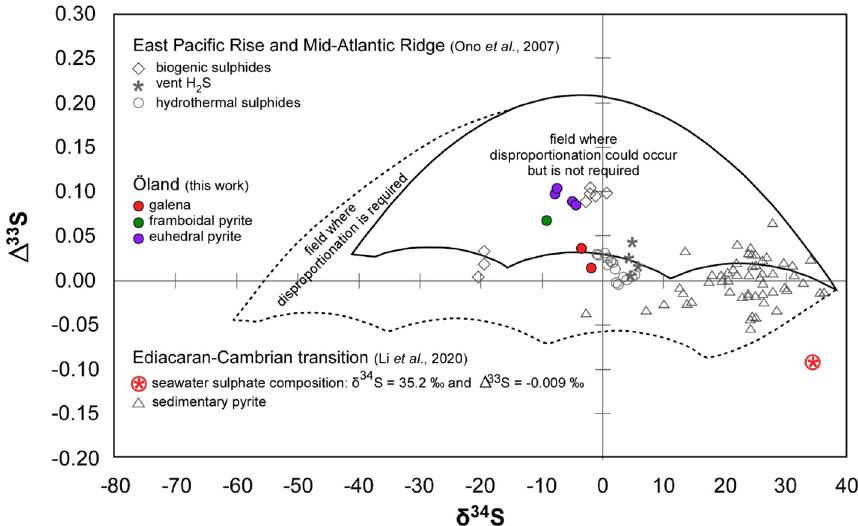
Figure 7. Plot of δ 34 S vs. ∆ 33 S for the Bruddesta pyrite and galena precipitates, compared to present-day biogenic and hydrothermal sulphide and vent H 2 S from the East Pacific Rise and Mid-Atlantic Ridge 41 and sedimentary pyrites from the Ediacaran ‒ Cambrian transition 42 . The model fields illustrate the field of S-isotope compositions produced by sulphate reduction where disproportionation could occur but not required (black outlined field) and sulphate reduction combined with sulphur disproportionation (black dotted line field) 43,44